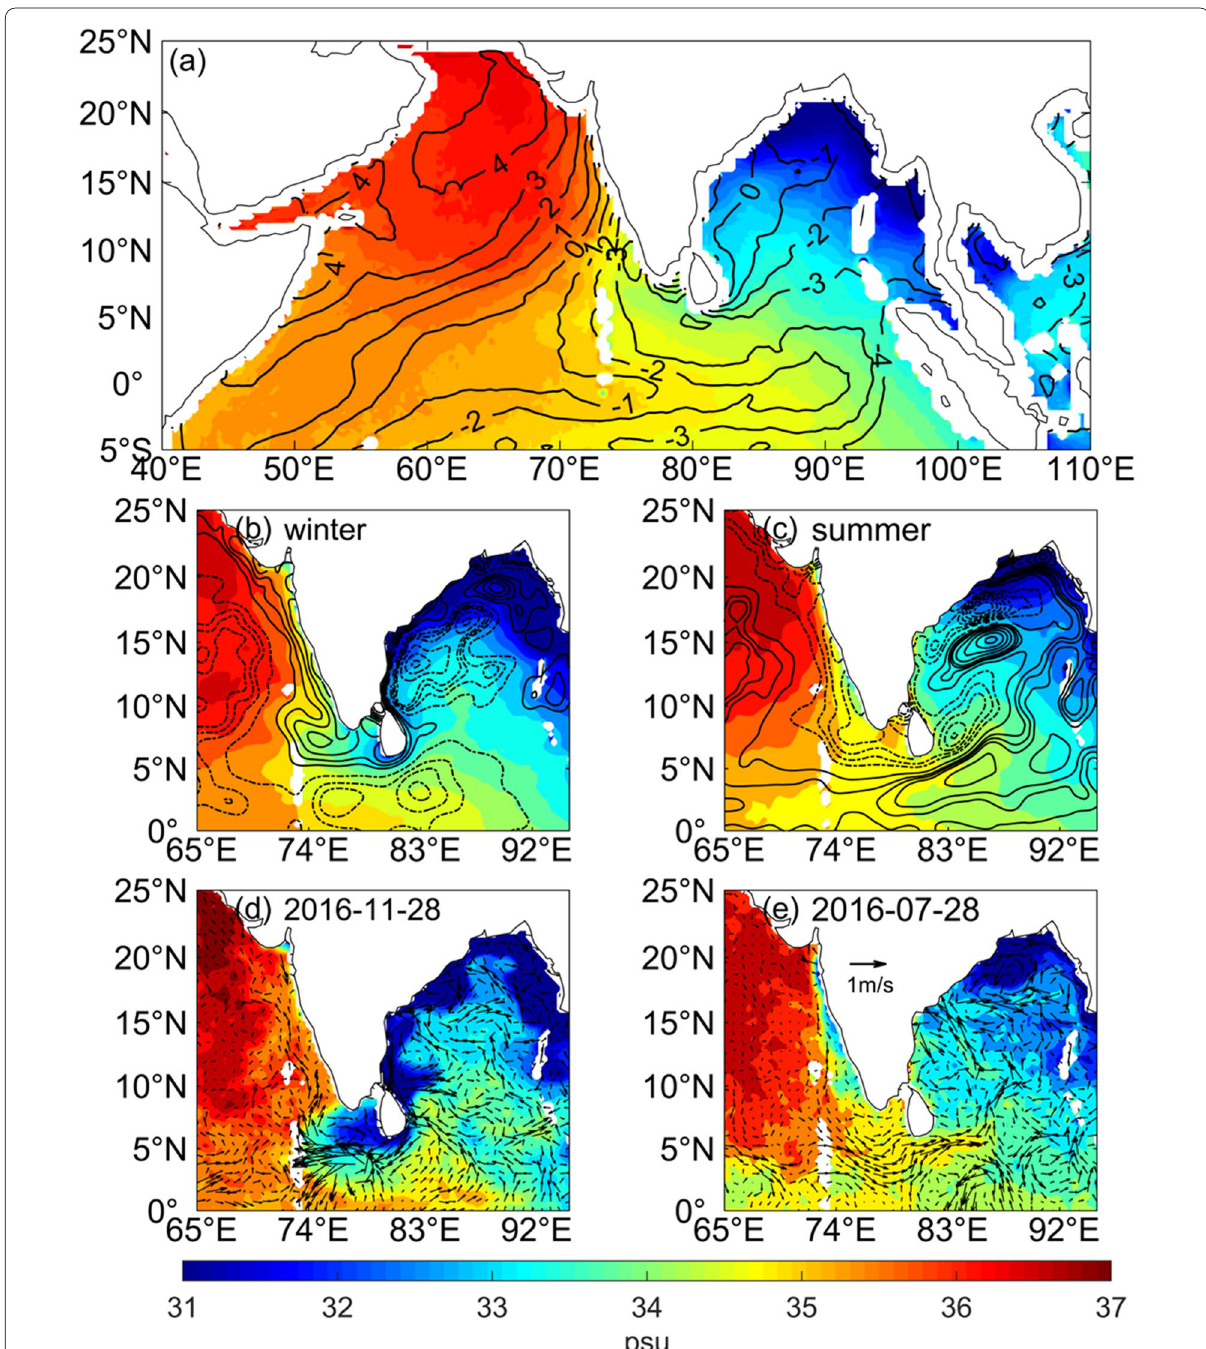
Fig. 1 Annual mean distribution of SSS in the North Indian Ocean and the inter-basin water transport in winter and summer, respectively. a Annual mean of SSS (shading, psu) and E minus P(contour lines, mm). b The five-year average winter SSS (shading, psu) and SLA (contours). c The five-year average summer SSS (shading, psu) and SLA (contour lines). The contour interval is 0.02 m with a span from SLA in the northern Indian Ocean (0.004m) is subtracted. d SSS (shading, psu) and sea surface current (vector, m / s) on Nov 28, 2016, and e same as d but for Jul 28,